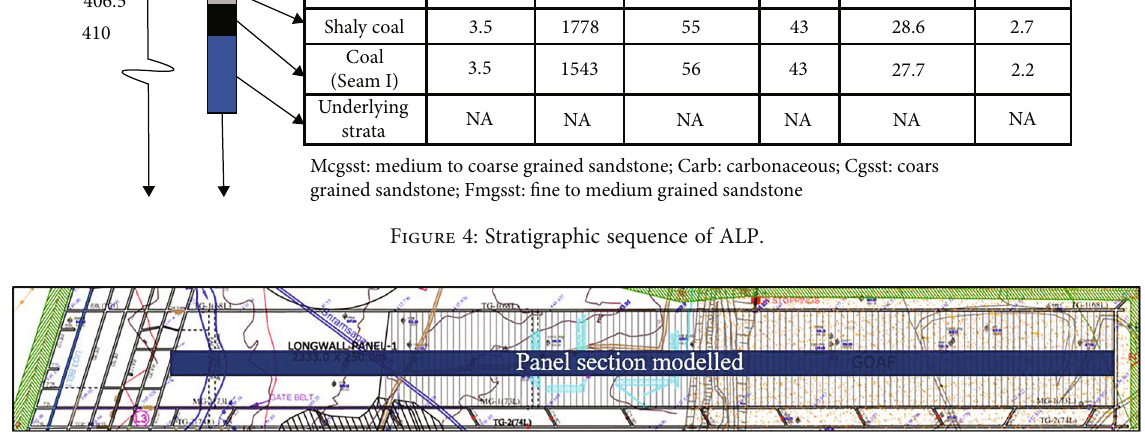
Figure 5: Midsection of panel 1 simulated in FLAC 3D (not to